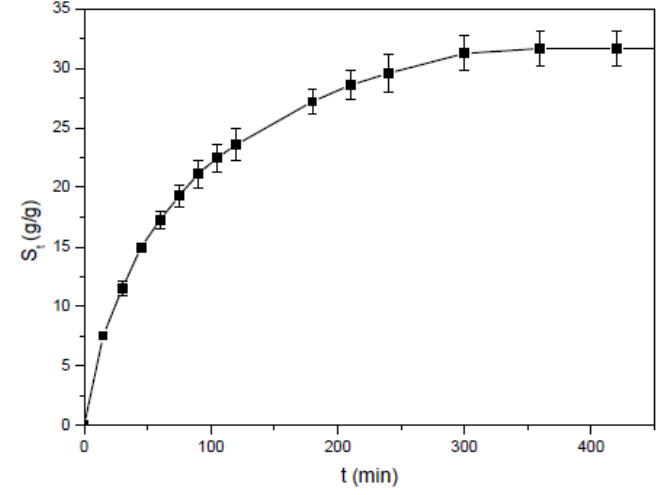
Figure 5. Effect of time on the swelling ratio of the hydrogel at 293 K.